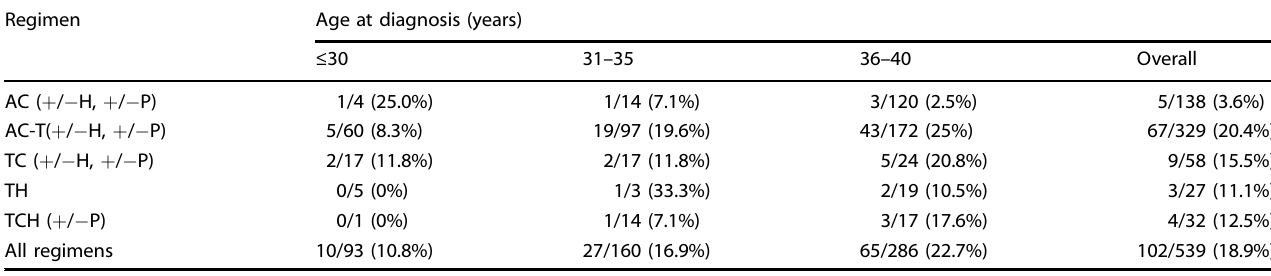
Table 4. Rates of 2-year treatment-related amenorrhea following common adjuvant chemotherapy regimens and overall by age.